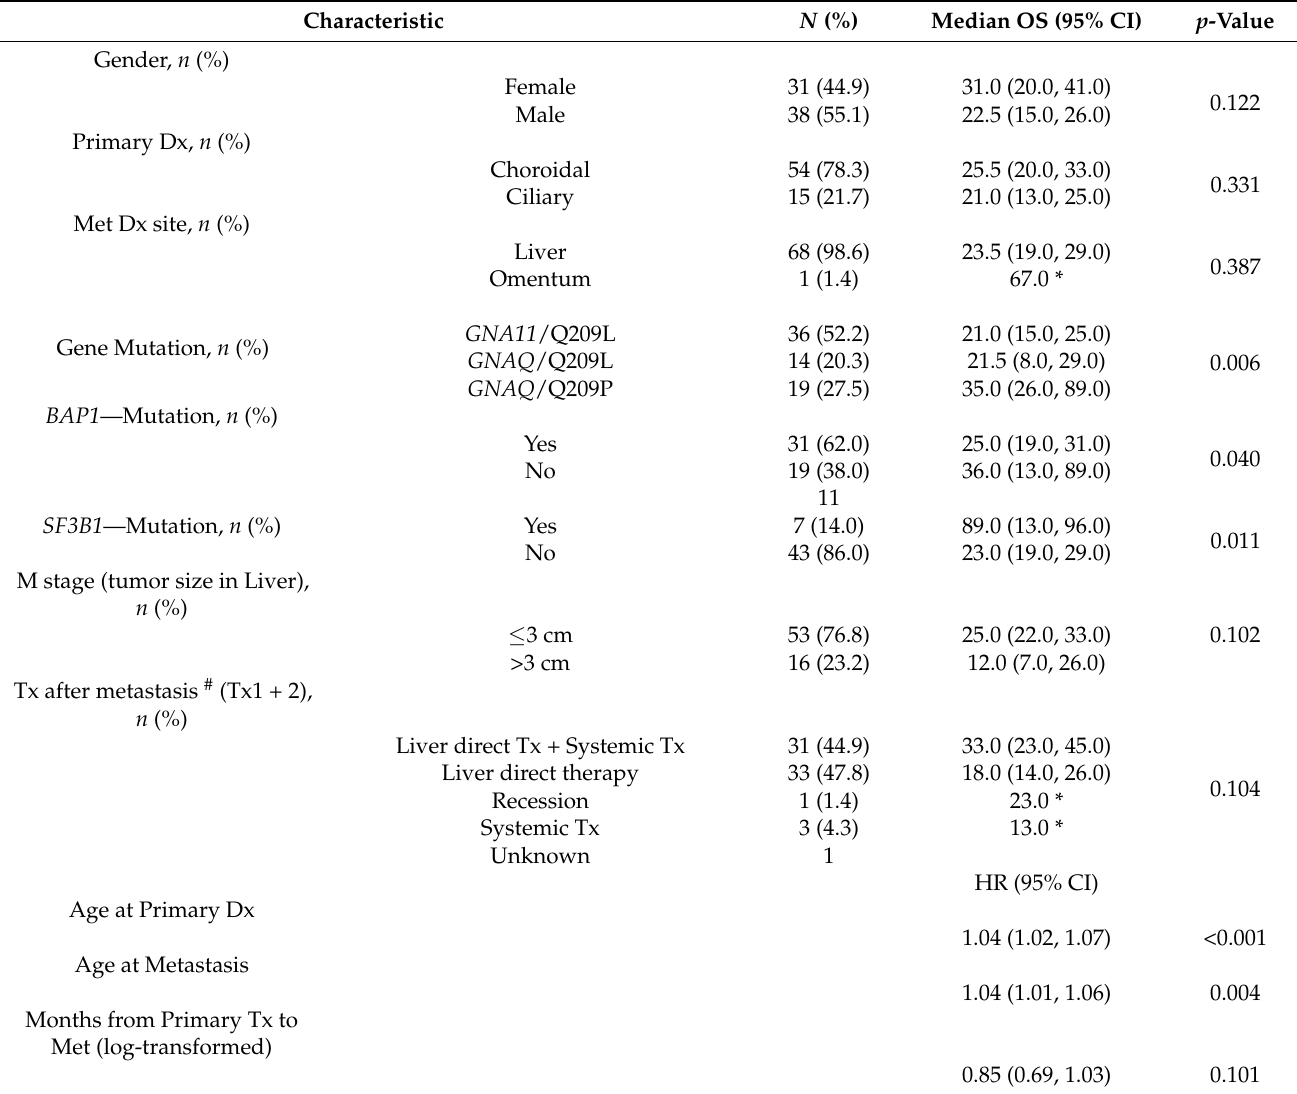
Table 4. Association between Patients Characteristics and Survival from Metastasis. Characteristic